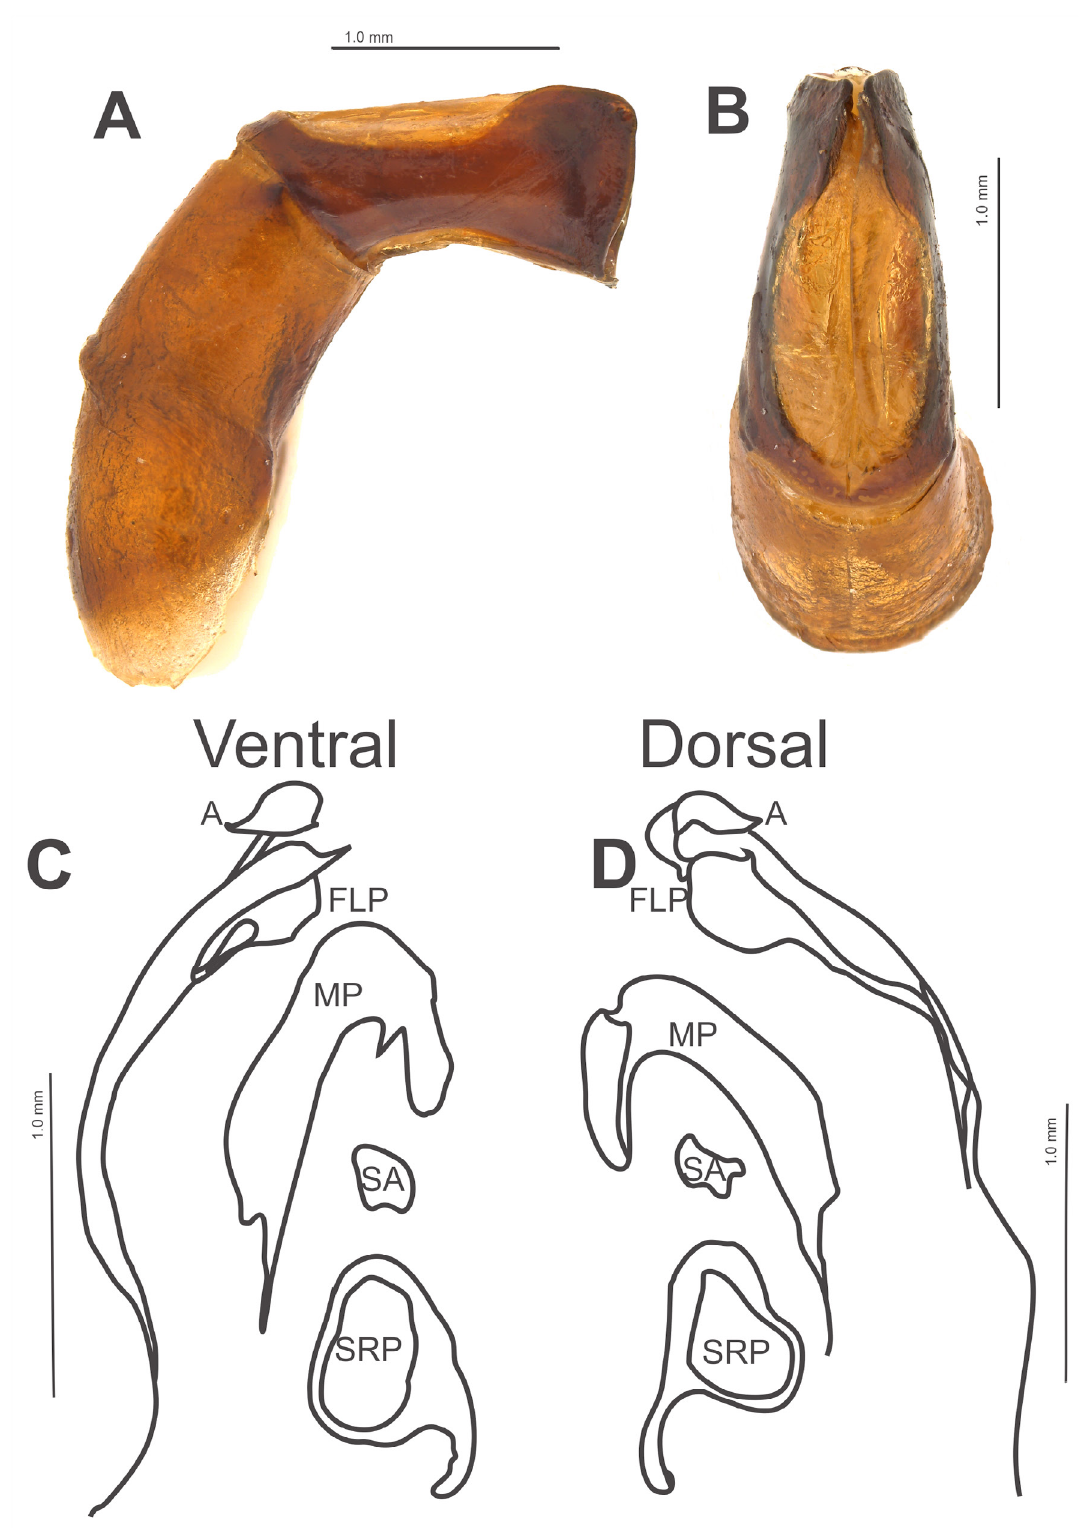
Fig. 2. Canthon ( Peltecanthon ) staigi (Pereira, 1953), ♂, Rio de Janeiro, Restinga da Marambaia (CEMT). A . Parameres lateral view. B . Parameres dorsal view. C . Internal sac ventral view. D . Internal sac dorsal view. Abbreviations: see Material and